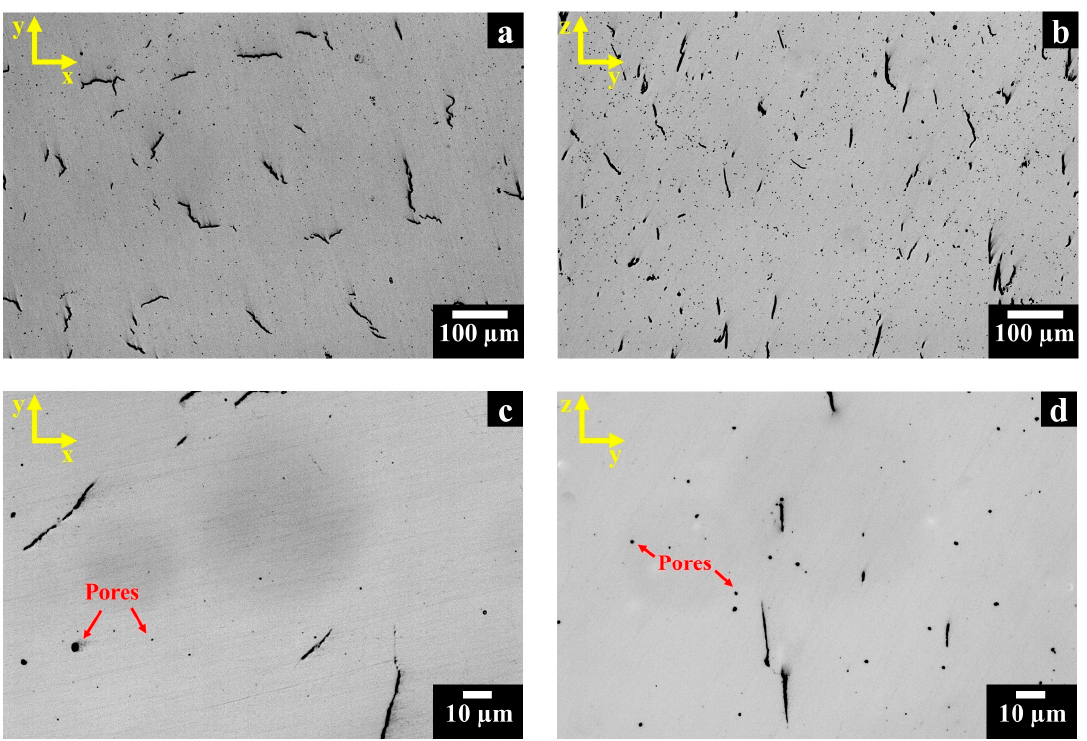
Figure 3. OM images of polished as-built HX samples showing: ( a , b ) cracks and pores along the x-y and z-y planes, respectively; ( c , d ) higher magnification exhibiting the near-perfect spherical shape of the micrometric pores along the x-y and z-y planes, respectively.